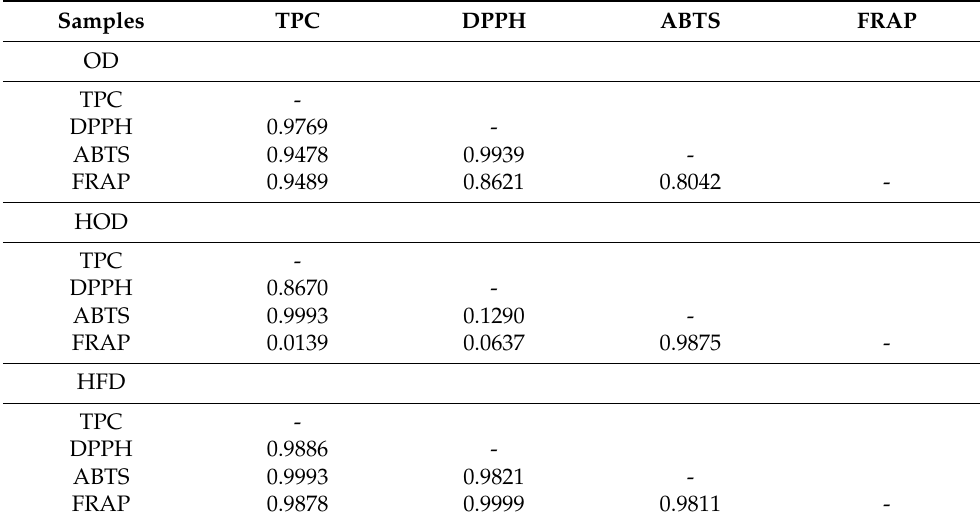
Table 3. Correlation analysis (coefficient of determination, R 2 ) between the spectrophotometric parameters (TPC, DPPH, ABTS, and FRAP), taking into consideration AP samples subjected to different drying treatments (OD, HOD,